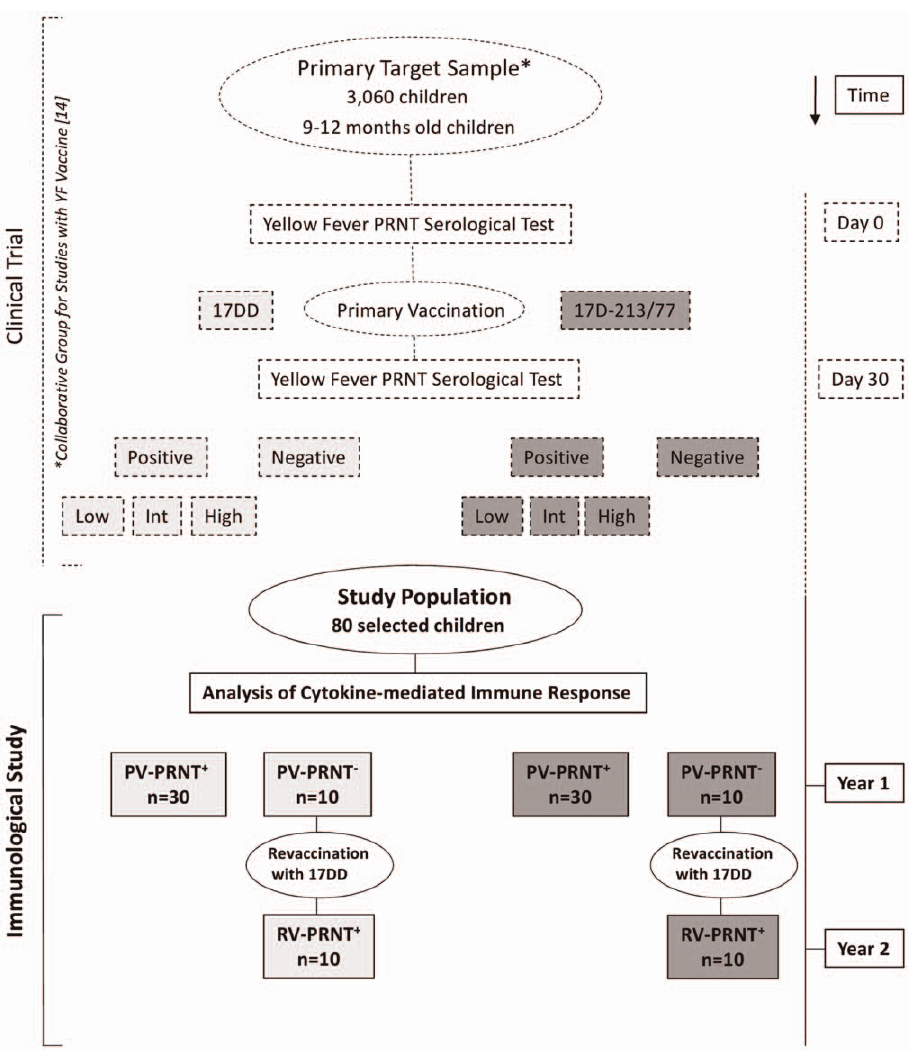
Figure 1. Flowchart of selection and follow-up of the Study Population from the Primary Target Sample. A total of 3,060 children, 9–12 months-old were elected for an epidemiological studies reported elsewhere [14] and referred as ‘‘Primary Target Sample’’. The Clinical Trial design is highlighted by dashed format. The study population enrolled in the present investigation was selected from the ‘‘Primary Target Sample’’ according to the PRNT results and comprise 30 PV-PRNT + and 10 PV-PRNT 2 individuals on each experimental arm (17DD and 17D-213/77), reaching a total of 80 volunteers. The current Immunological Study design is highlighted by solid format.